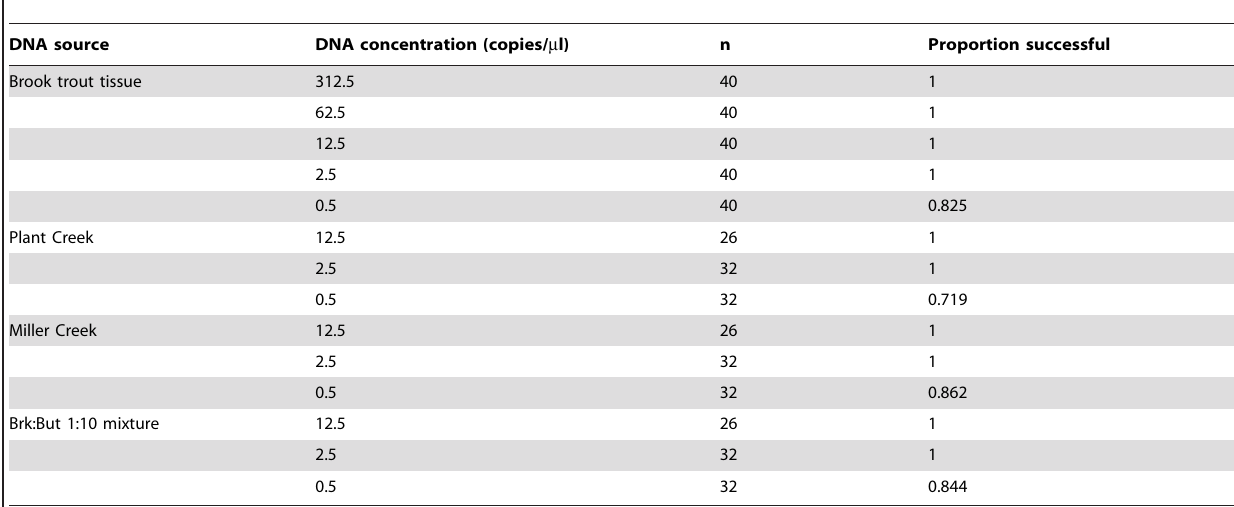
Table 3. Assay BRK2 sensitivity results.